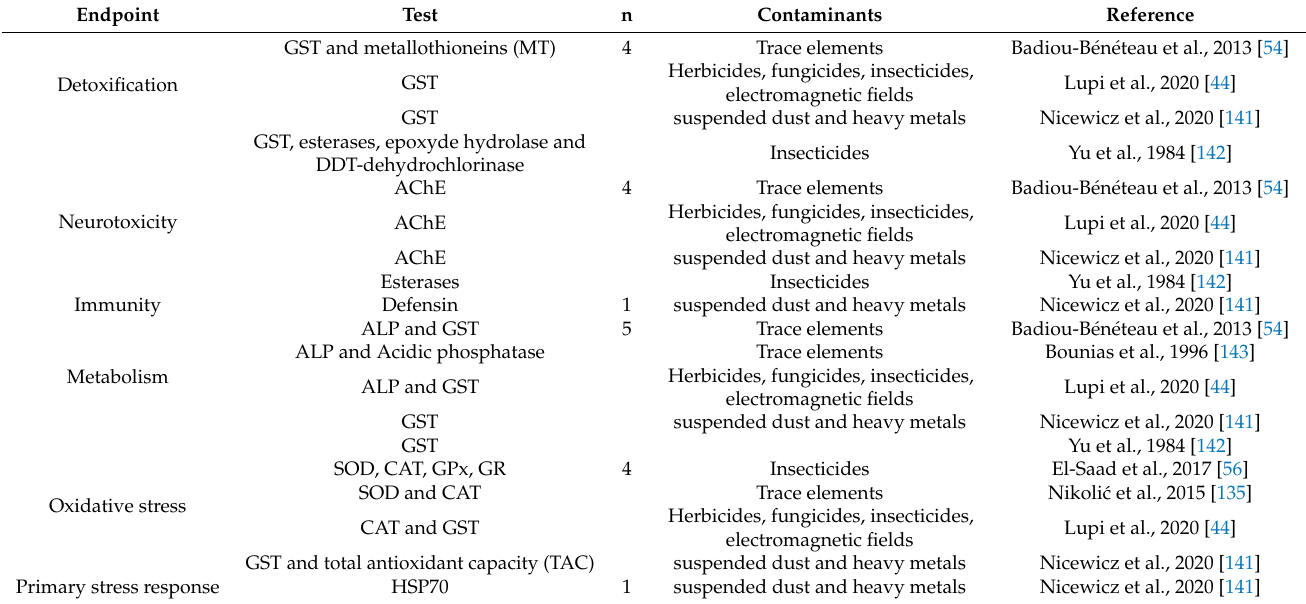
Table 6. Summary of field studies divided by molecular and enzymatic endpoint and